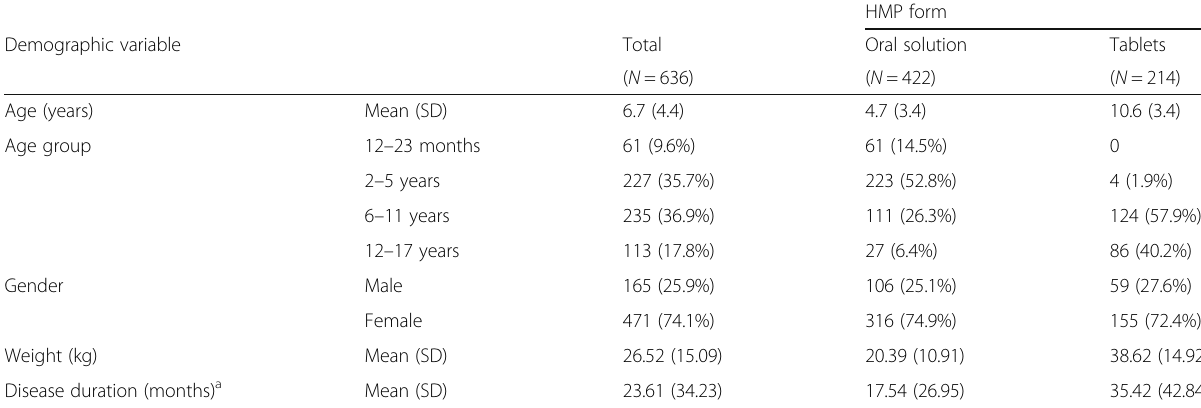
Table 2 Patient characteristics (all enrolled patients)